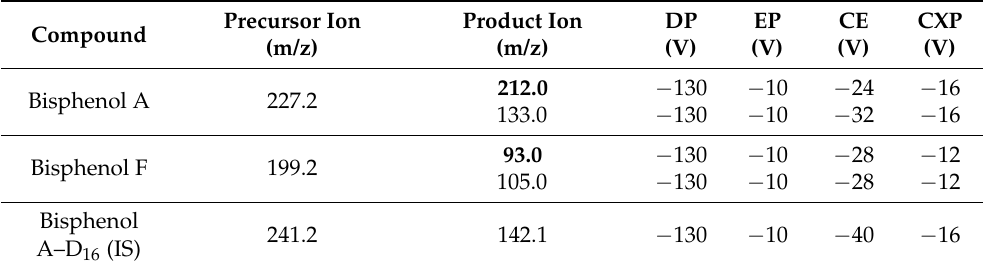
Table 2. UHPLC–MS/MS parameters for the multiple reaction monitoring (MRM) acquisition mode. Precursor Ion Compound